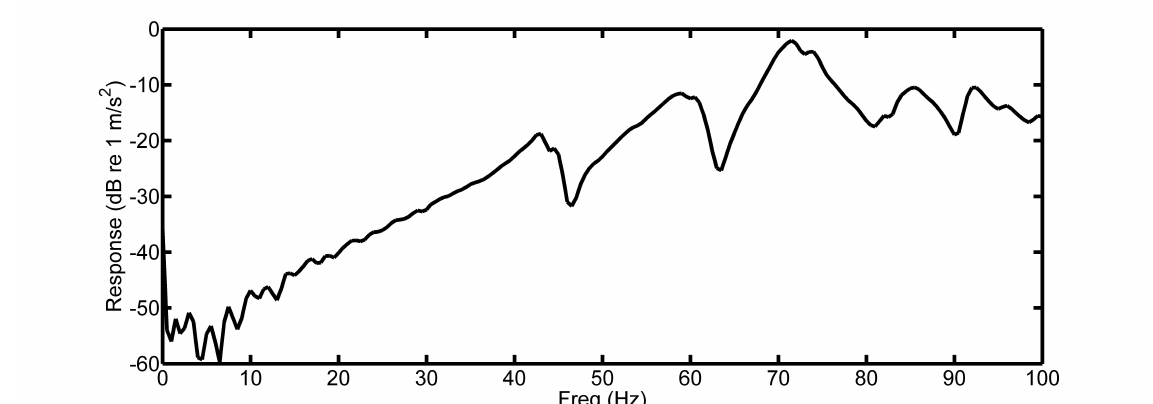
Figure 9. Supporting beam frequency response